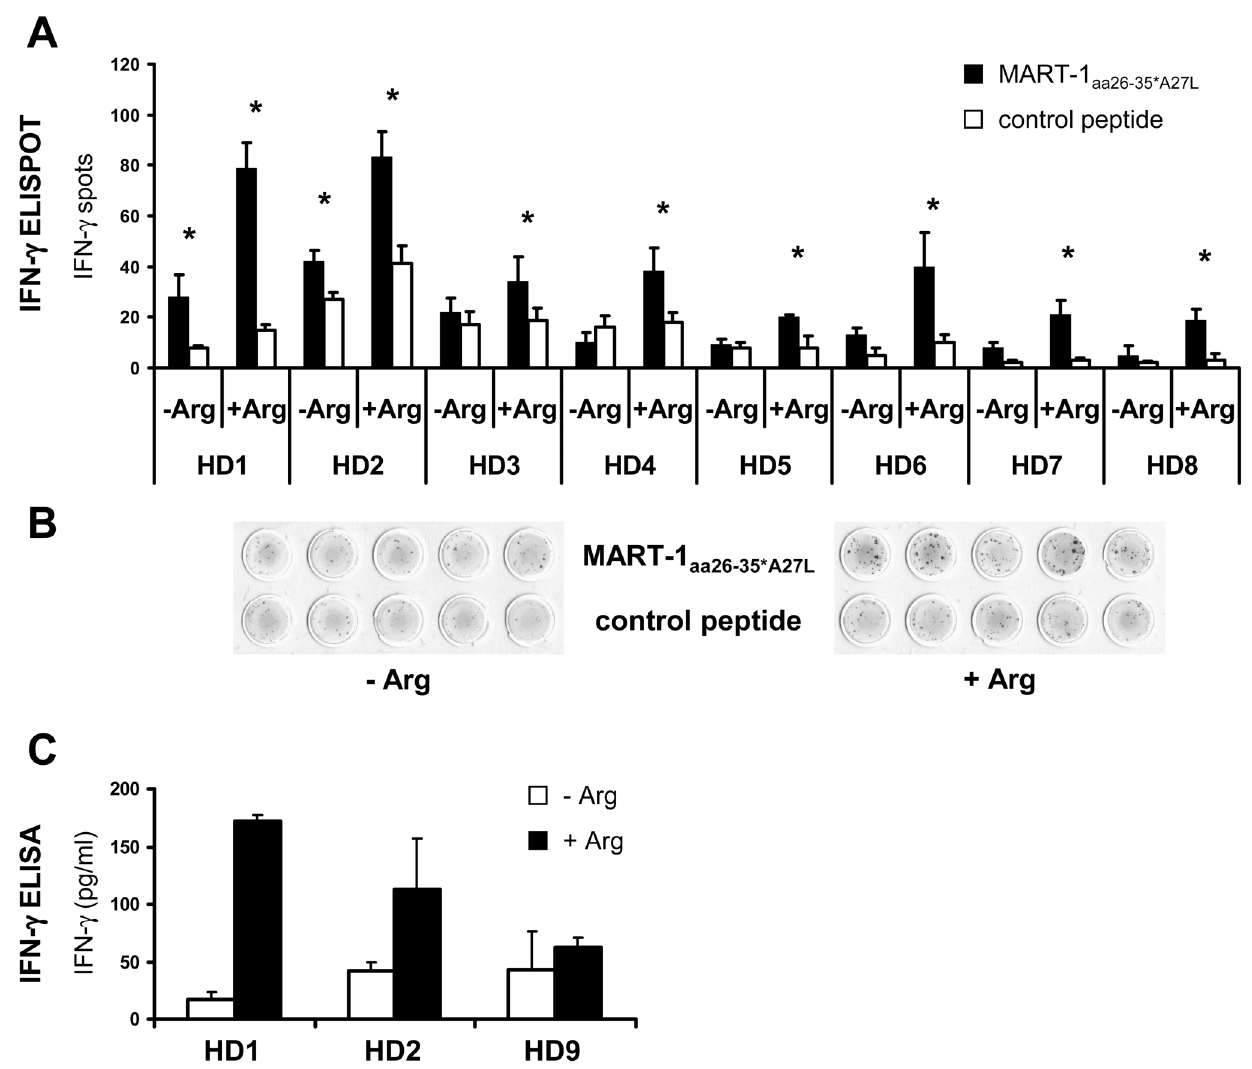
Figure 2. Impact of arginine depletion on activation of tumor antigen specific T cells analyzed by IFN- c ELISPOT and IFN- c ELISA. CD8 + MART-1 aa26–35*A27L specific T cells were expanded by activation with MART-1 aa26–35*A27L peptide loaded DC. CD8 + T cells were then restimulated with T2 cells loaded with MART-1 aa26–35*A27L peptide or control peptide for 24 h in ELISPOT assays in the presence of arginine ( + Arg, 1000 m M) or in arginine-free cell culture medium ( 2 Arg). A Results of all positive IFN- c ELISPOT assays are presented: Black bars depict median numbers of IFN- c spots for T cells incubated with MART-1 aa26–35*A27L peptide loaded T2 cells and white bars show stimulation with irrelevant control peptide.